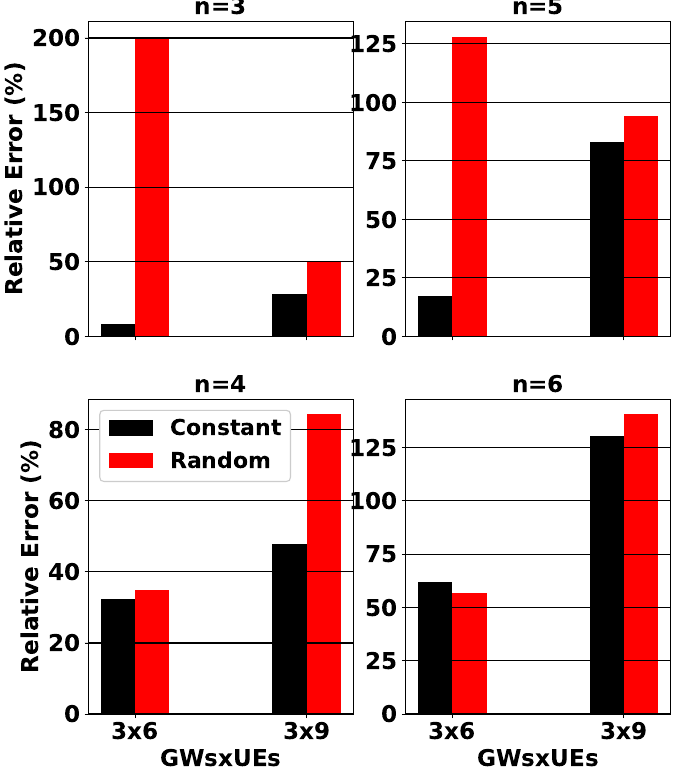
Figure 3. Average Relative Error between Exhaustive and Proposed Schemes, with Constant and Random Initial Feasible Points, for Different n th Order in 3 × 6 and 3 × 9 HTS